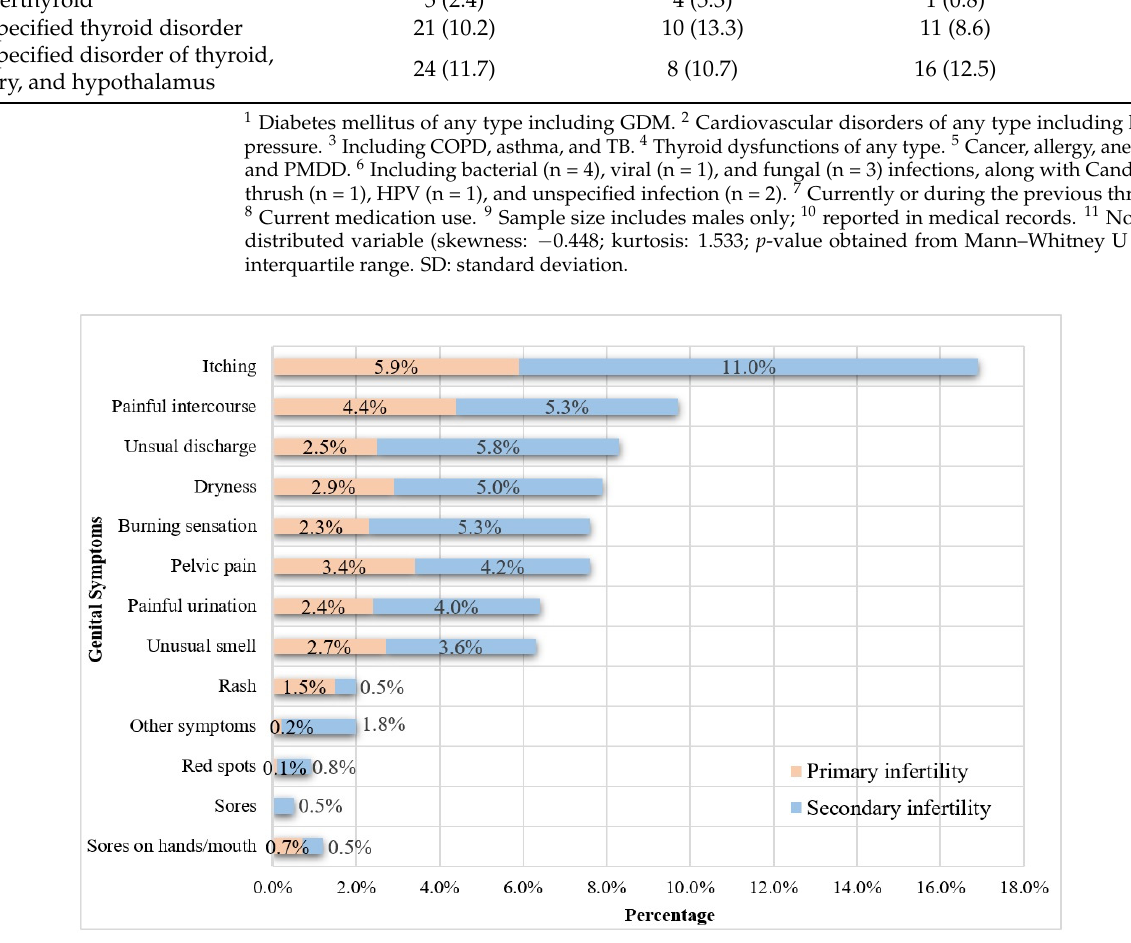
Figure 2. Genital symptoms reported by the fertility clinic attendees according to the type of infer ‐ tility. Table 2. Lifestyle characteristics of fertility clinic attendees, and the distribution between primary and secondary infertility.